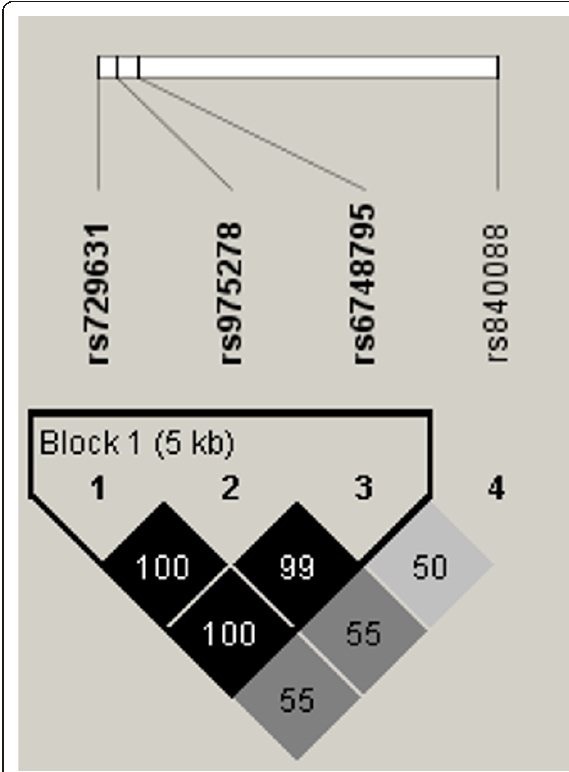
Figure 1 Linkage disequilibrium (LD) between the studied SERPINE2 polymorphisms among Finnish Caucasian construction workers . Values of D ’ are shown. The haplotype structure was estimated by using the Haploview program, version